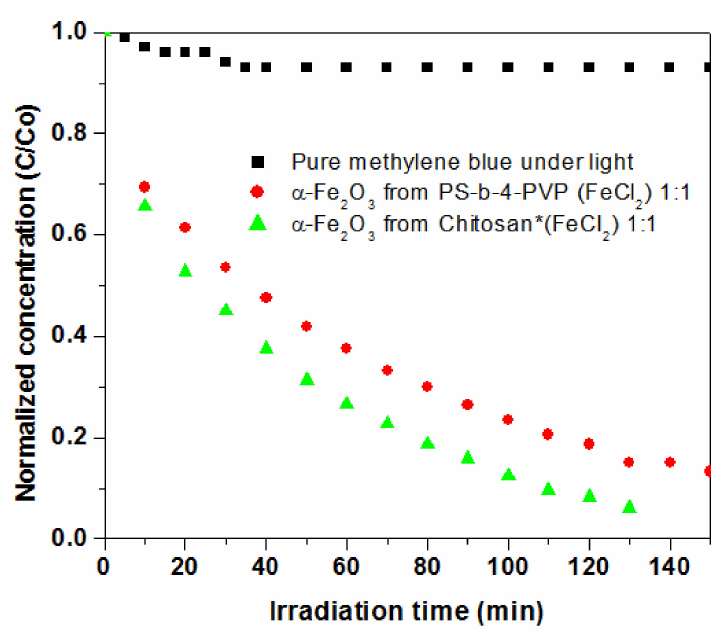
Figure 21. Normalized concentration changing of MB without catalyst, in the presence of a-Fe 2 O 3 · PS- co-4-PVP and in the presence of a-Fe 2 O 3 · chitosan. Adapted from reference